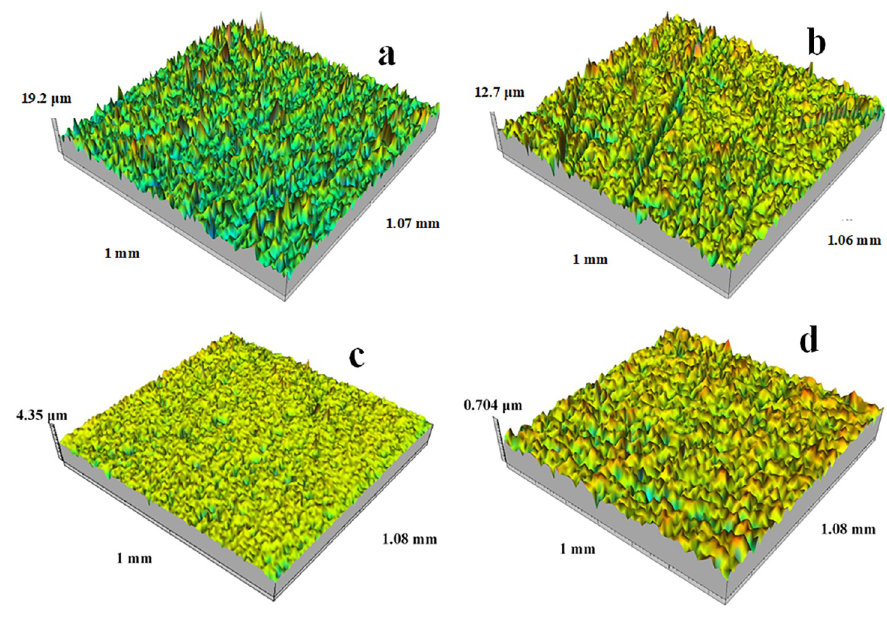
Fig 2. Initial morphology of four types of surfaces. (a) the multimodal surface with larger height. (b) Multidirectional grooved surface with a larger height. (c) the multimodal surface with smaller height. (d) Multidirectional grooved surface with a smaller height.